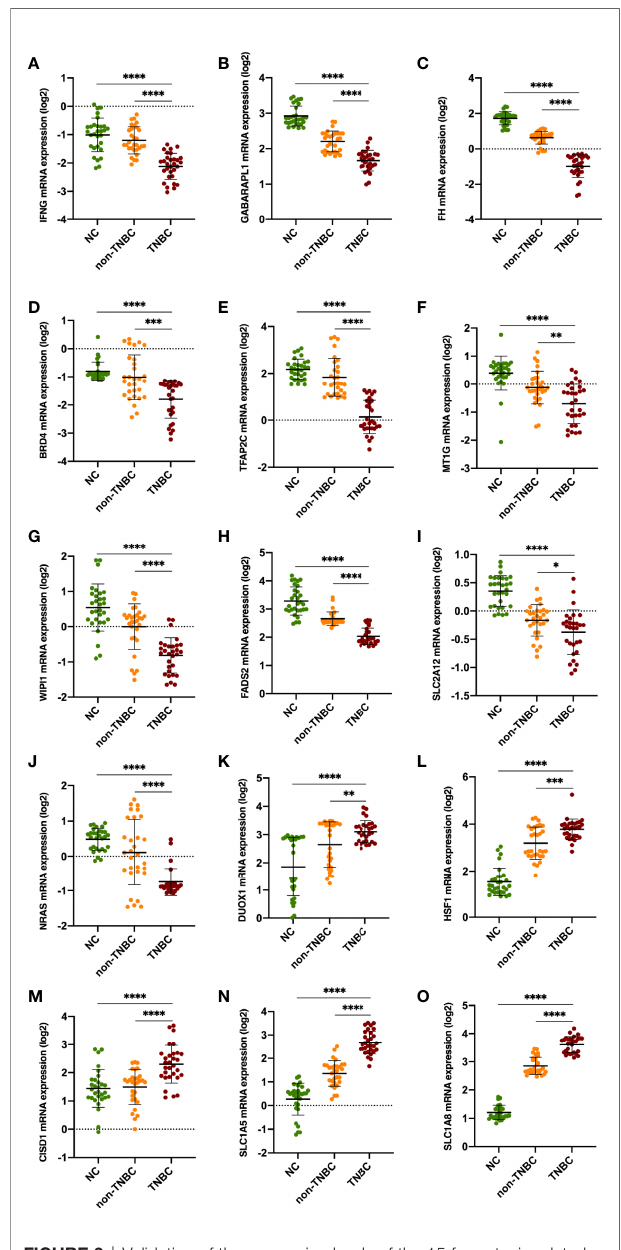
FIGURE 3 | Validation of the expression levels of the 15 ferroptosis ‐ related genes in clinical specimens. Student ’ s t-test (two-tailed) was used for the comparison analyses. *P < 0.05, **P < 0.01, ***P < 0.001 ****P < 0.0001